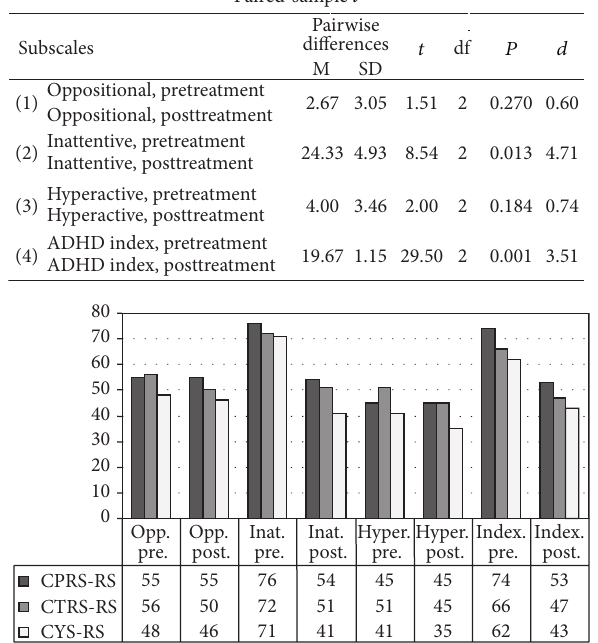
= 48.67 index; 𝑀 = 73.00 (SD pre = 2.65) versus 𝑀 pre post = 6.81 ), paired-sample 𝑡 (2) = 8.54; 𝑃 < .01 , one-tail, (SD Figure 2: Conners Rating Scale for Parents (CPRS-RS), Teachers post and Cohen’s 𝑑 = 4.71 (Figure 2). (CTRS-RS), and Boy (Conners Youth Self-report Rating Scale, CYS-RS); 𝑇 scores in baseline (pretreatment) and with MPH treatment (posttreatment). Pairwisedifferences calculation has been performed between pre- and posttreatment scores. These scores corresponded to the mean values between parents, teachers, and self-report scores at CPRS, calculated for all four subscales: (1) oppositional, (2) inattentive, (3) hyperactive, and (4) ADHD index).